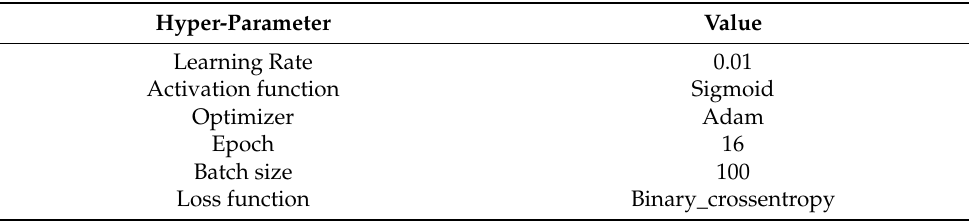
Hyper-parameters Setting: Table 3 shows the values of hyper-parameters used in experiments with VGG16 for binary classification. Table 3. Hyper-parameters for experiments with